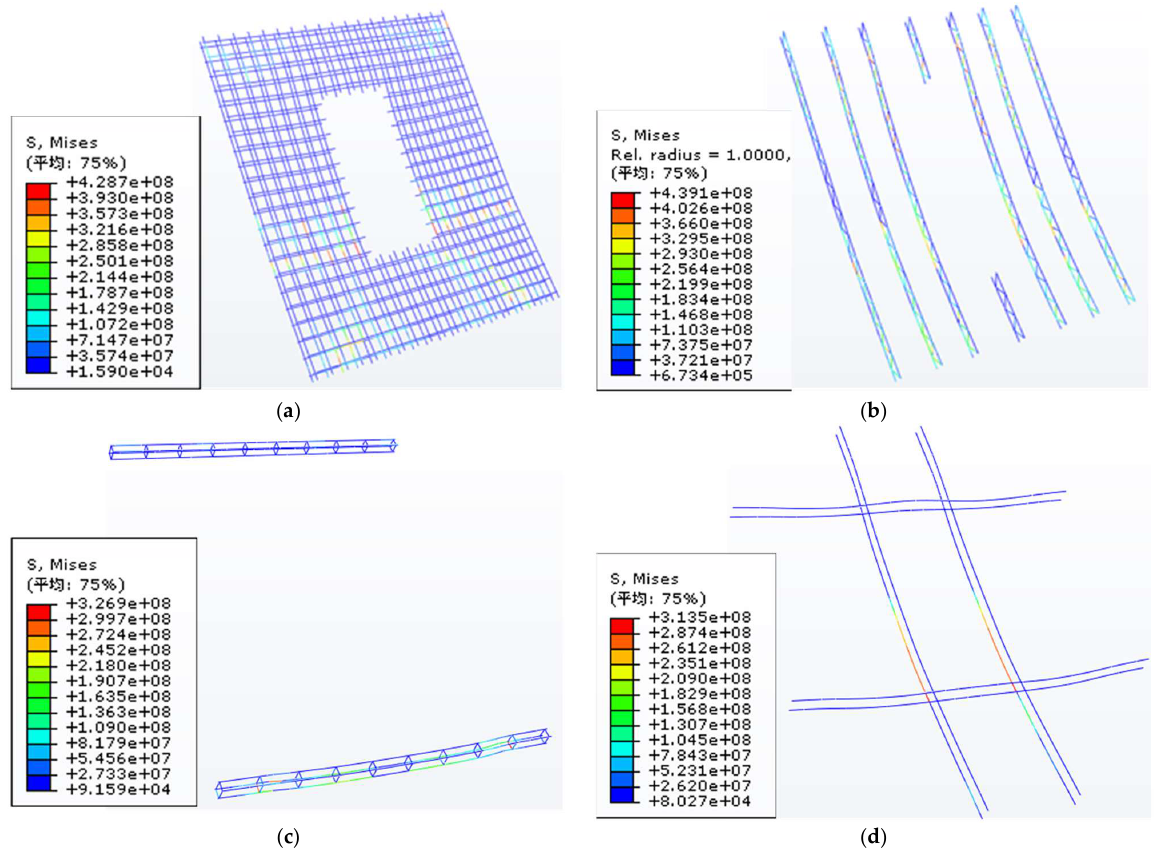
Figure 14. Stress distributions of specimen WP. ( a ) Stress of reinforcement wire. ( b ) Stress of steel truss parallel to the span. ( c ) Mises stress contour plots of steel truss perpendicular to the span. The non-English term ‘ 平均 ’ means ‘Average’.